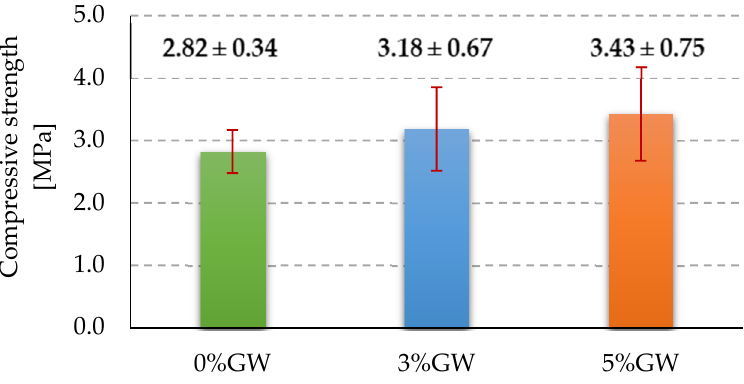
Figure 7. Compressive strength of tested materials.